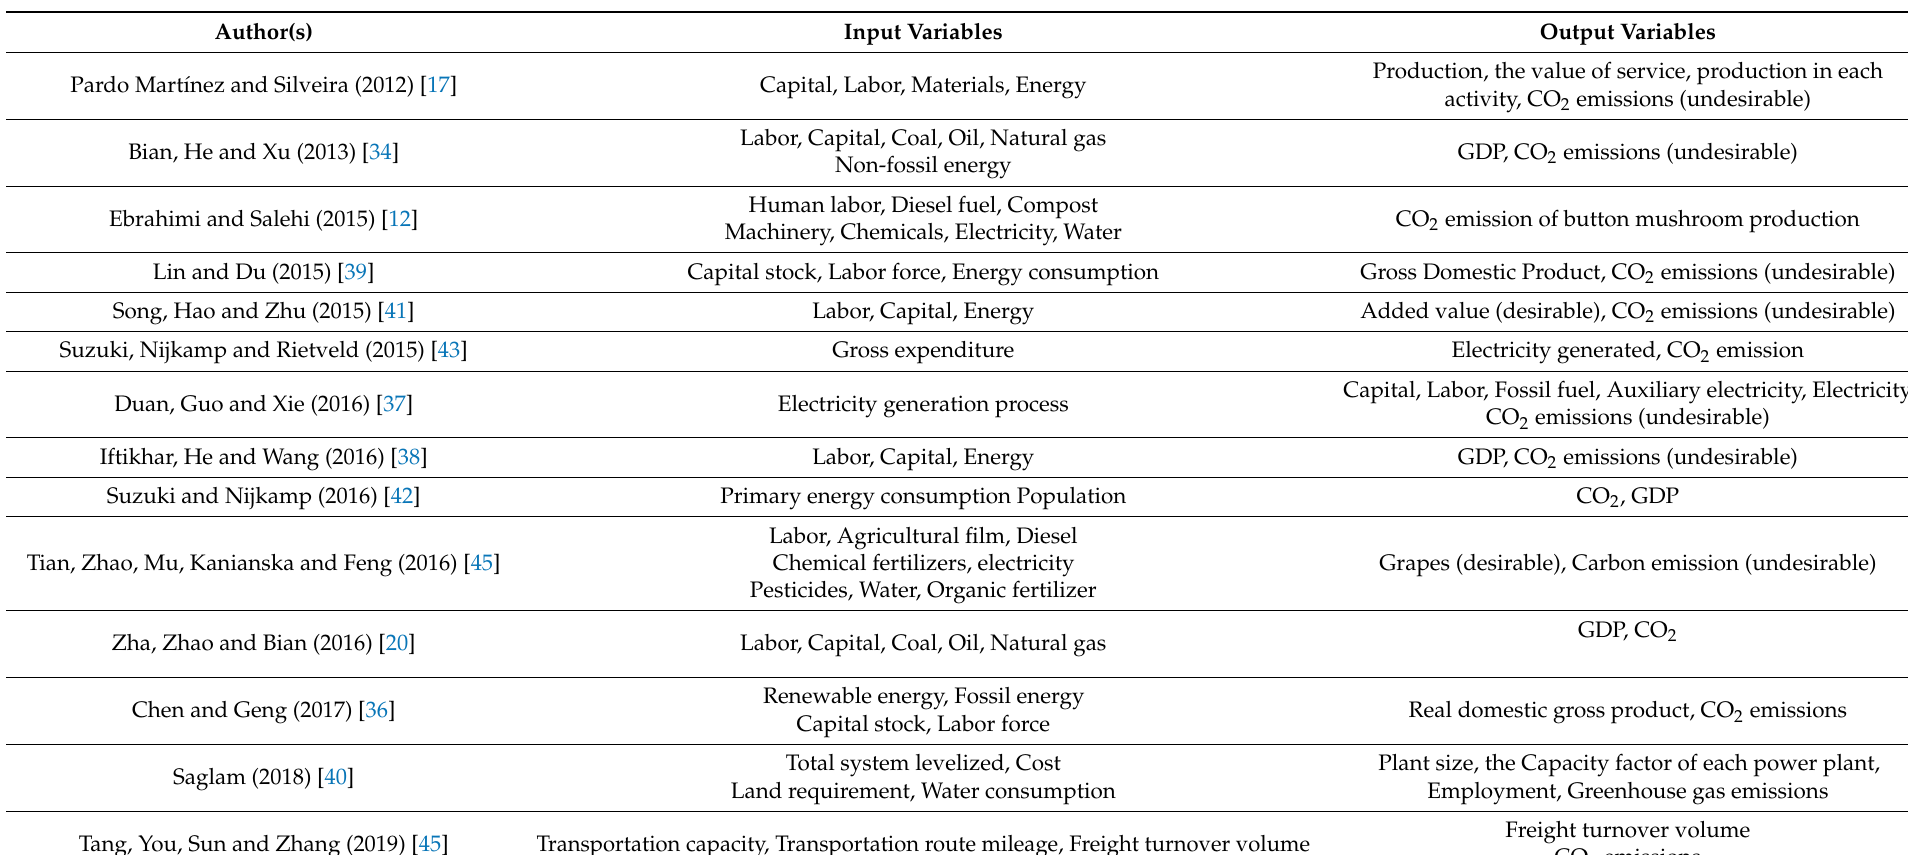
Table 2. Variables inputs/outputs used by researchers on environmental efficiency